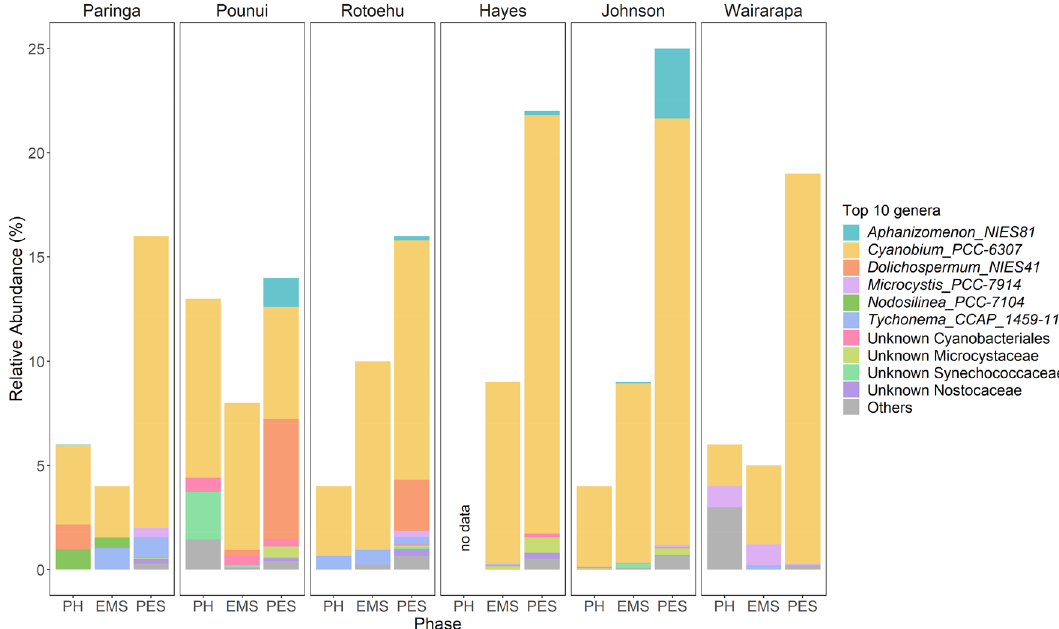
Figure 5. Relative abundance of the top 10 most abundant photosynthetic cyanobacterial genera across all lakes, less abundant genera are grouped as “Others”. All samples were grouped by Phase within each lake. PH = Pre-Human; EMS = Evidence of Māori Settlement; PES = Post-European Settlement. The sediment core from Lake Hayes does not include any PH phase.